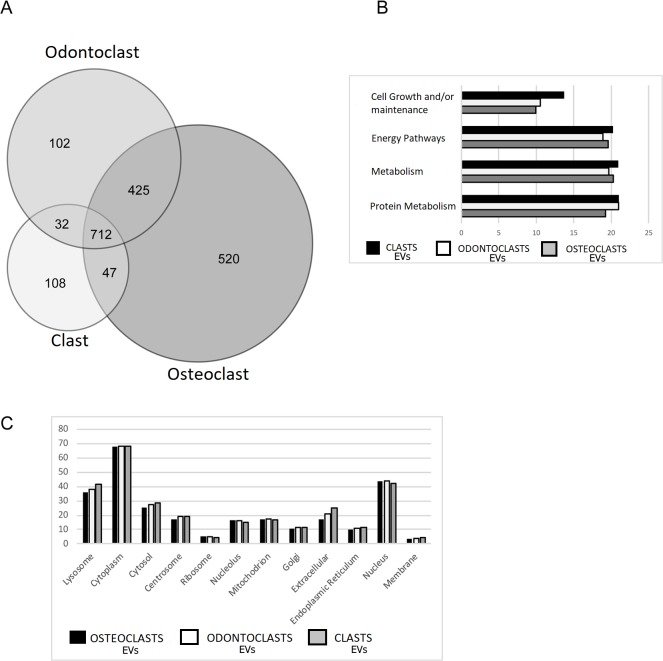
Overview of protein composition of EVs from clastic cells.(A) Venn diagram of proteins detected from osteoclasts, odontoclasts and clasts. (B) Comparison of the gene ontology biological pathways represented by 10% or more of the total proteins in EVs. (C) Selected primary cellular location of proteins detected in clastic EVs. These locations were abundant and indicative of the general feature that there was little difference between the groups of clastic EVs.